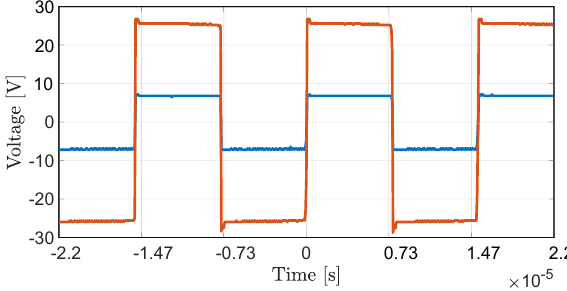
Figure 14. Primary (Red), and secondary (Blue) voltage waveform of the proposed